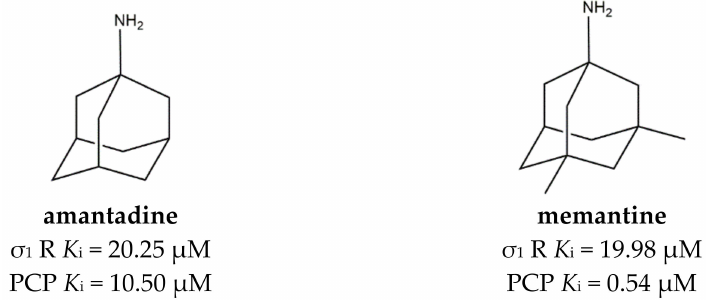
Figure 9. Amantadine and memantine structures and their K i values for σ 1 receptor ( σ 1 R) and the phencyclidine binding site at the N-methyl-D-aspartate receptor (PCP)